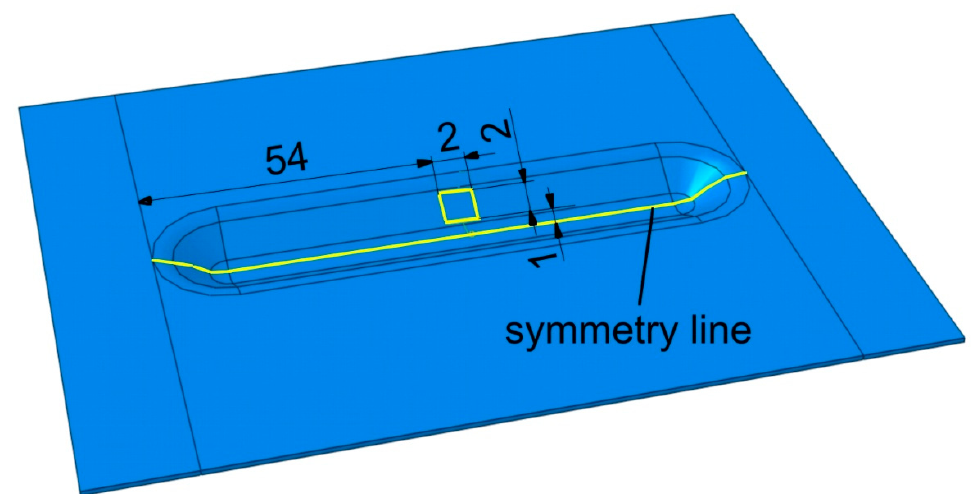
Figure 2. Location of measurement of the surface roughness in the inner surface of the stiffening